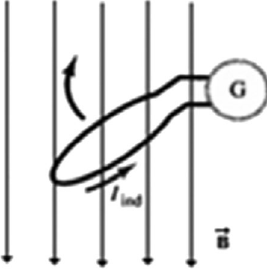
FIG. 8. The coil is rotating in a stationary magnetic field.